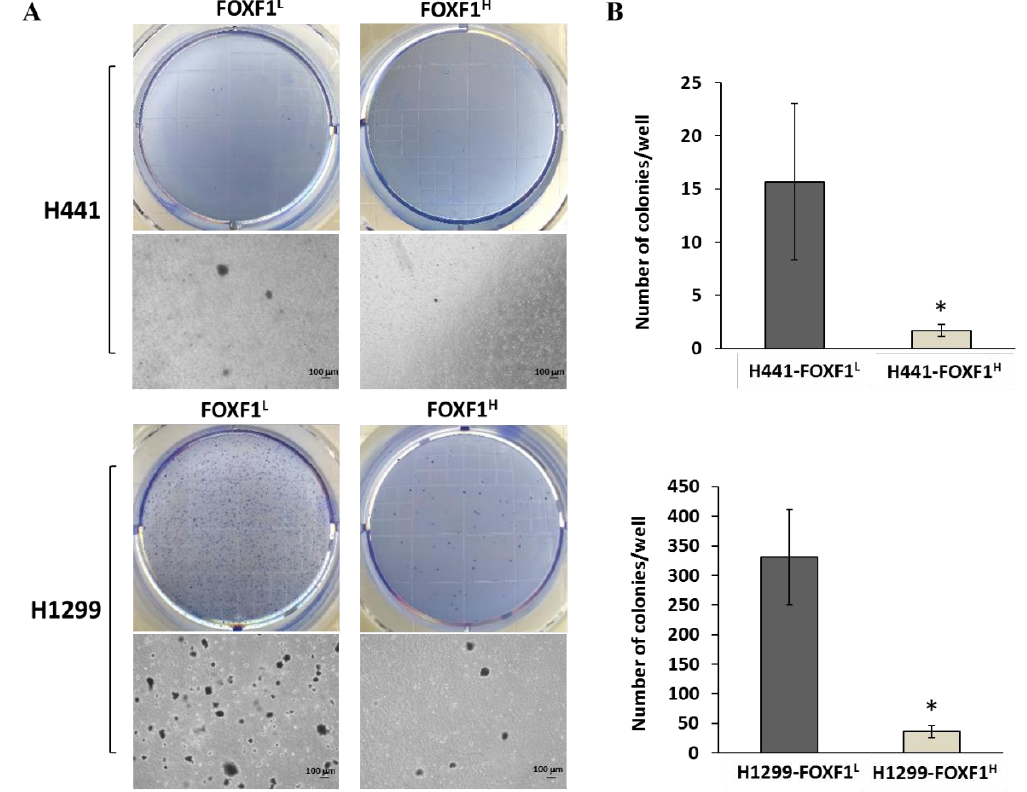
Figure 5. Analysis of anchorage-independent growth ability of highly expressing FOXF1 NSCLCs.